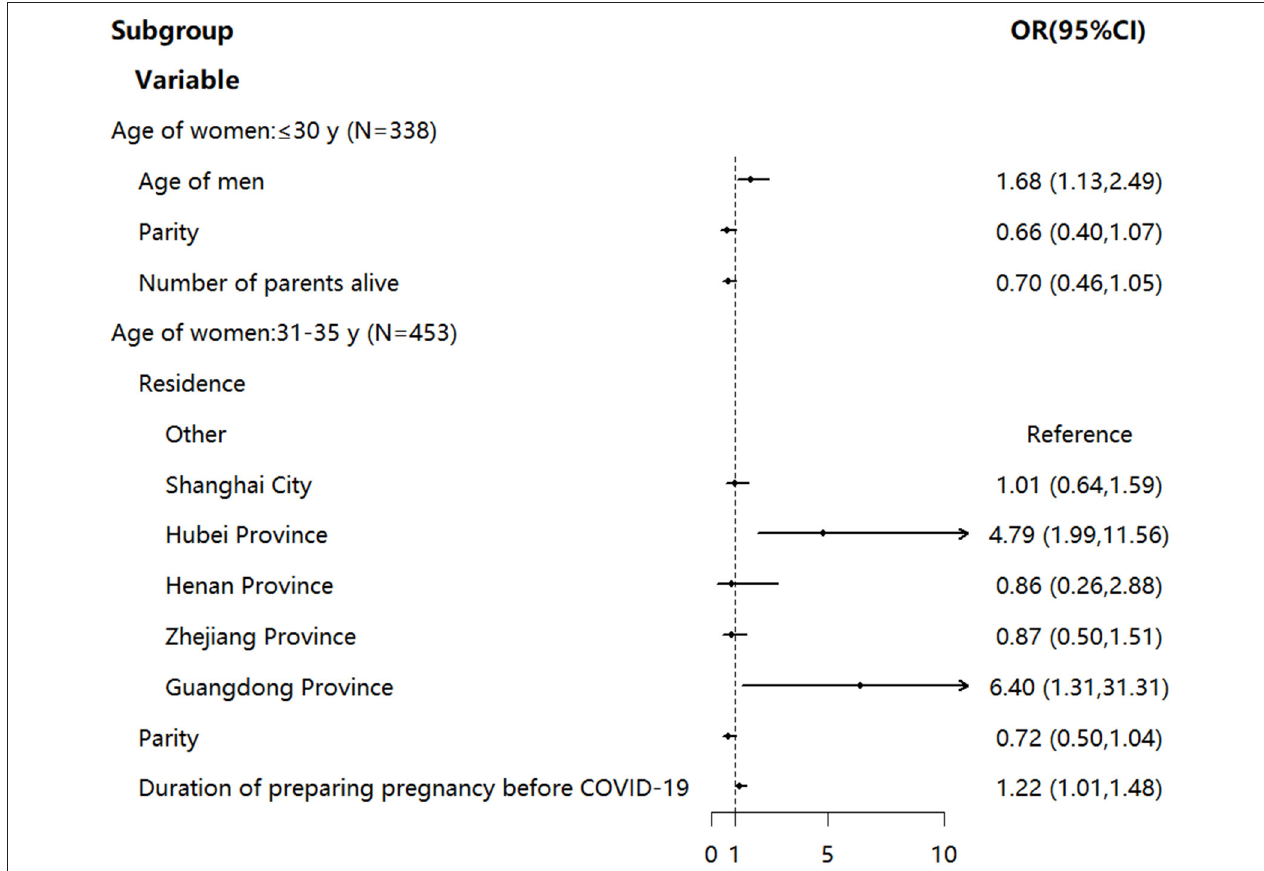
FIGURE 1 | Subgroup multivariable logistic regression analysis (respondents with fertility intention before COVID-19). OR was indicated by an arrow if the value exceeded 10. OR, odds ratio; CI, confidence